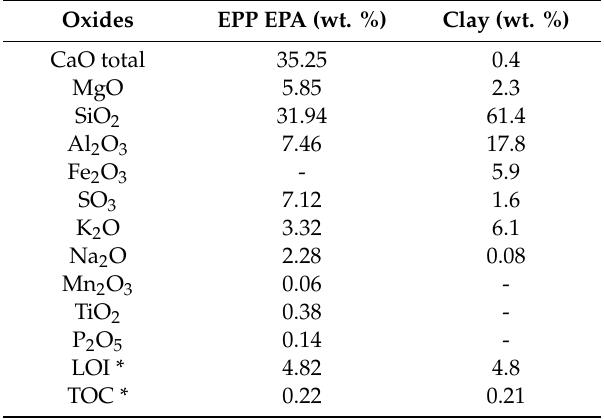
Table 4. Chemical composition of EPP-EPA and clay.